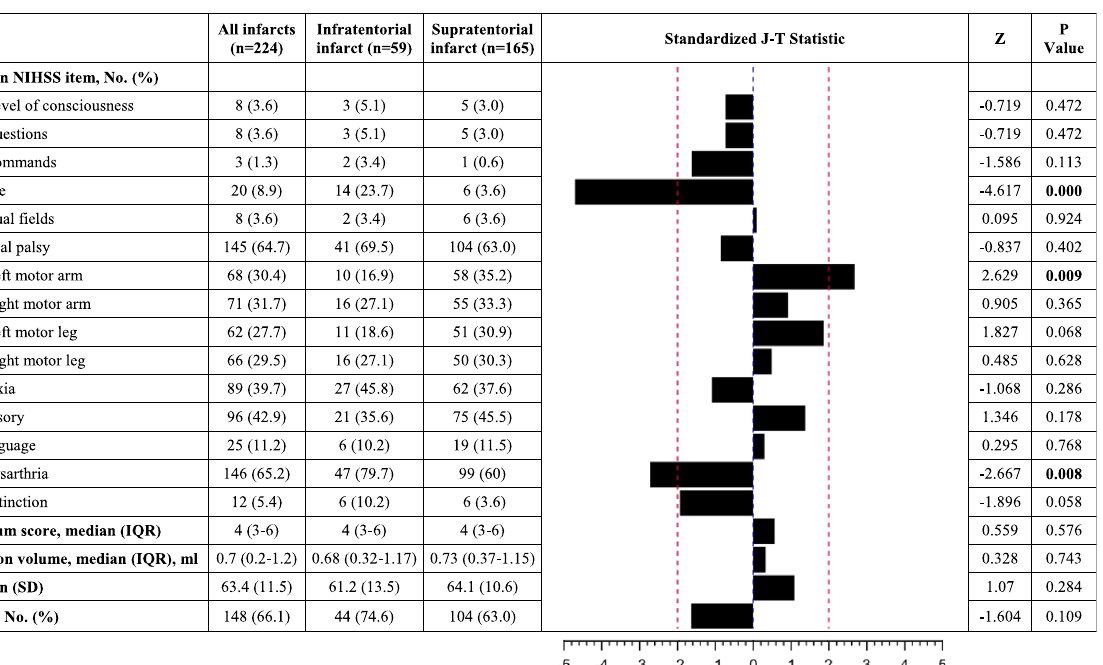
Fig. 2 Standardized Jonckheere-Terpstra (J-T) statistics. DWI, diffusion weighted imaging; NIHSS, National Institute of Health Stroke Scale. Standardized Jonckheere-Terpstra (J-T) statistics (Z scores) depicting strength and direction of associations between supratentorially located infarcts and individual independent variables. Positive values (right section of bar graph) signify symptoms more commonly observed in supratentorial lacunar lesions. Negative values (left side of bar graph) indicate symptoms predominantly occurring in infratentorial lacunar lesions. The broken red lines mark the levels where P =